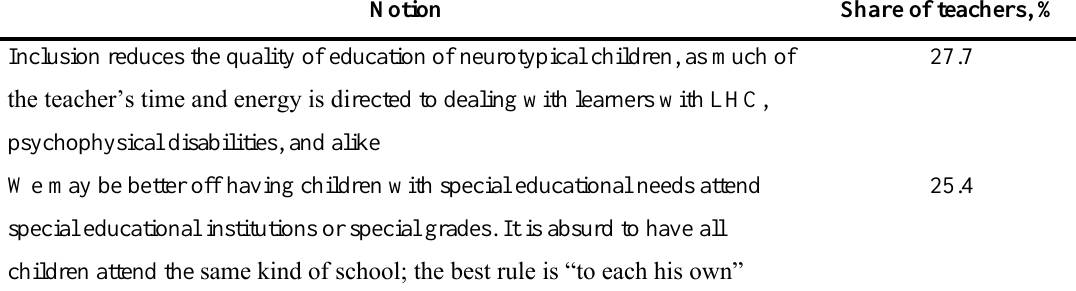
Table 4. Teachers’ Erroneous and Naïve-Mythological Notions about Inclusive Education